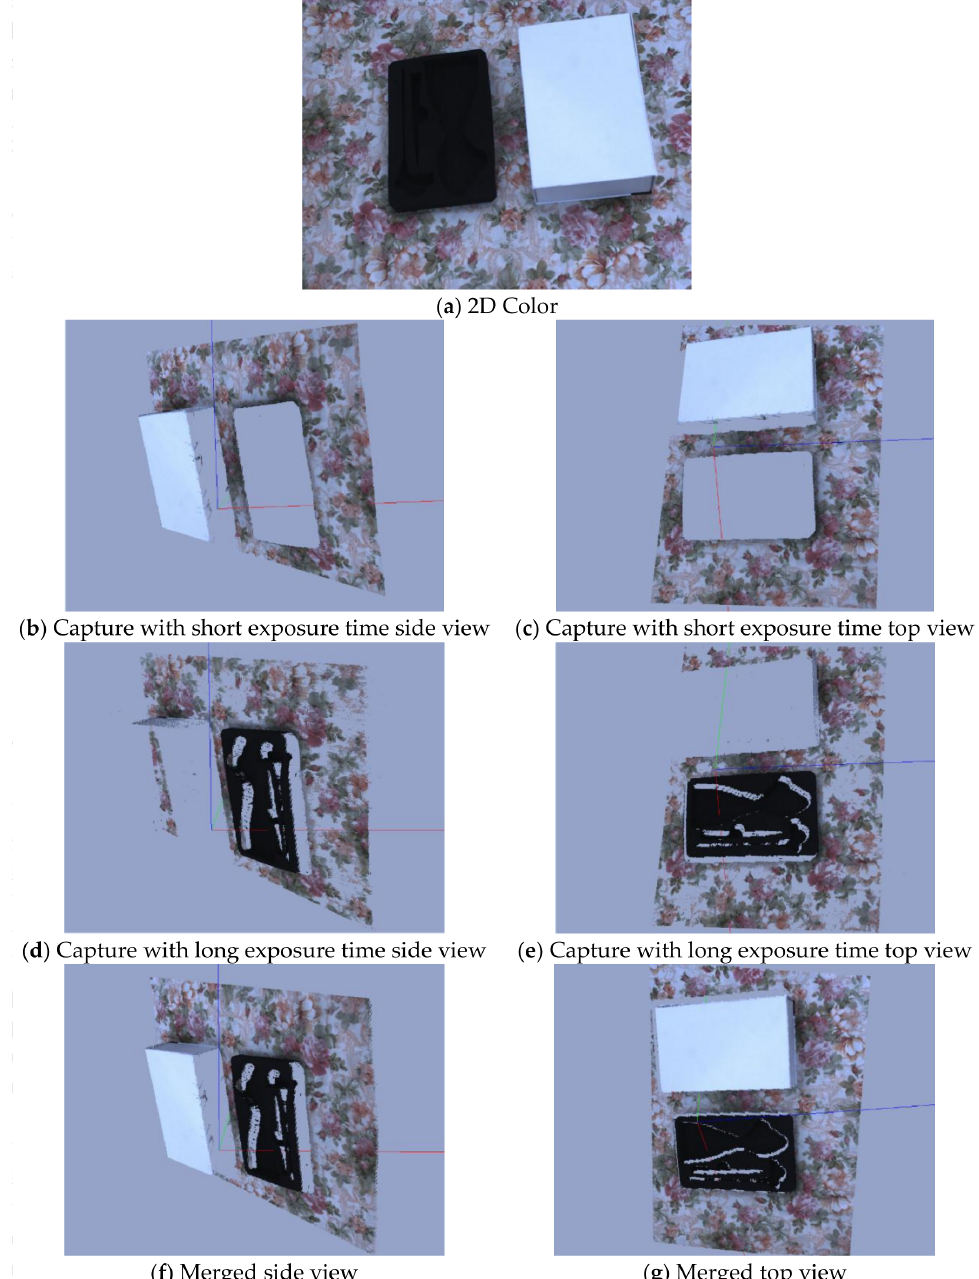
Figure 17. ( a ) 2D color image of the scene; ( b , c ) side and top view of 3D output captured with short exposure time, respectively; ( d , e ) side and top view of 3D output captured with long exposure time, respectively; and ( f , g ) side and top view of point cloud obtained after merging the point cloud obtained through short and long exposure times,